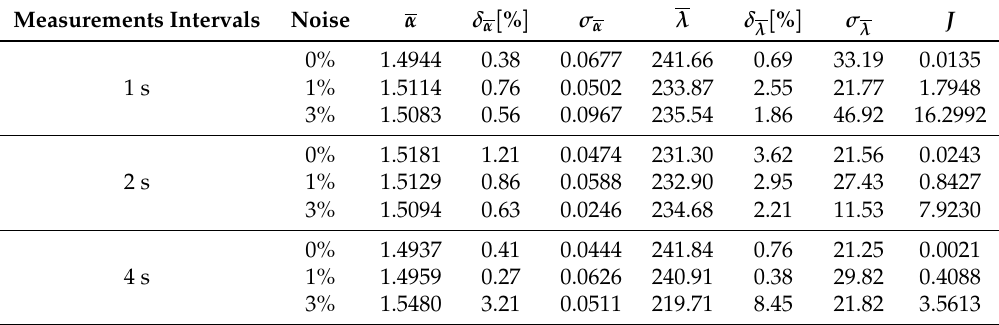
Table 1. Results of calculations in the case of four measurement points ( α i —reconstructed value of order derivative, λ i —reconstructed value of diffusion coefficient, δ —the relative error of reconstruction, σ —standard deviation, J —the value of functional).